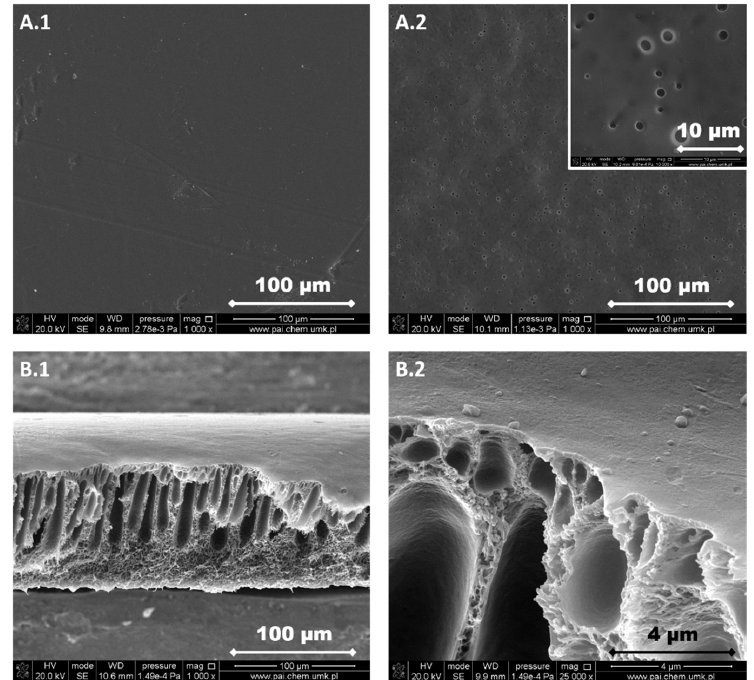
Figure 3. SEM images of M1 membrane. ( A.1 ) Selective layer, ( A.2 ) support layer, ( B.1 ) a cross-section of the membrane, and ( B.2 ) a cross-section of the membrane at higher magnification.